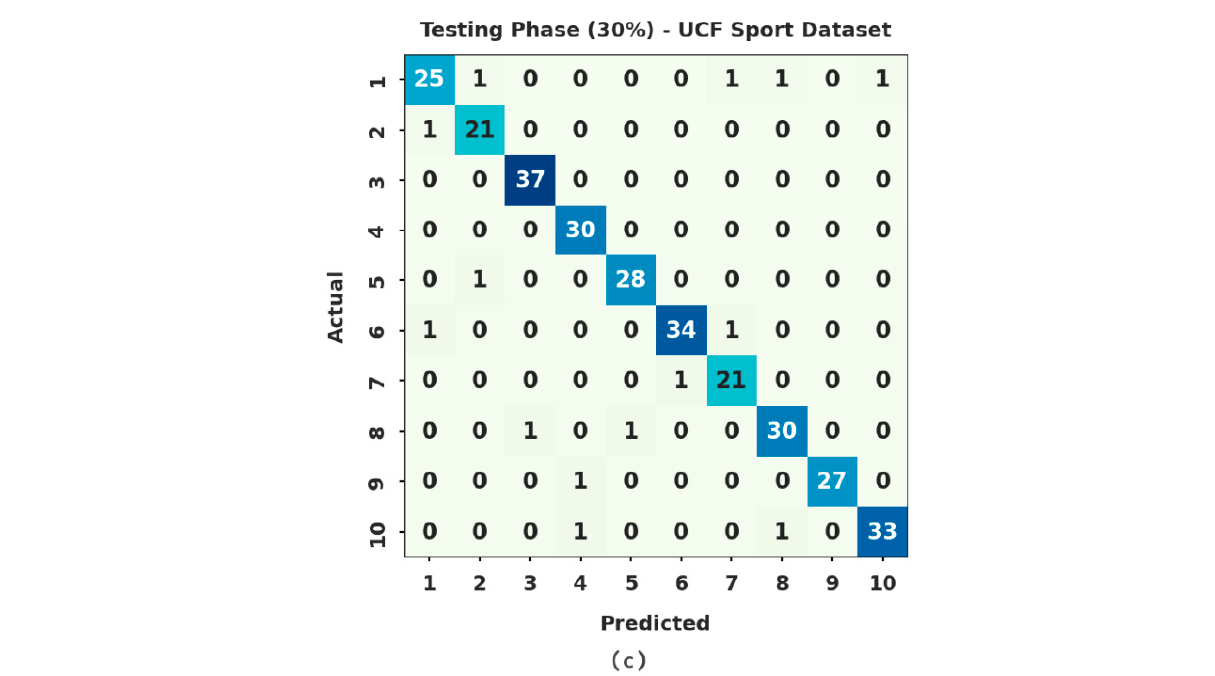
Figure 6. Confusion matrix of QWSA-HDLAR model on UCF Sport dataset.